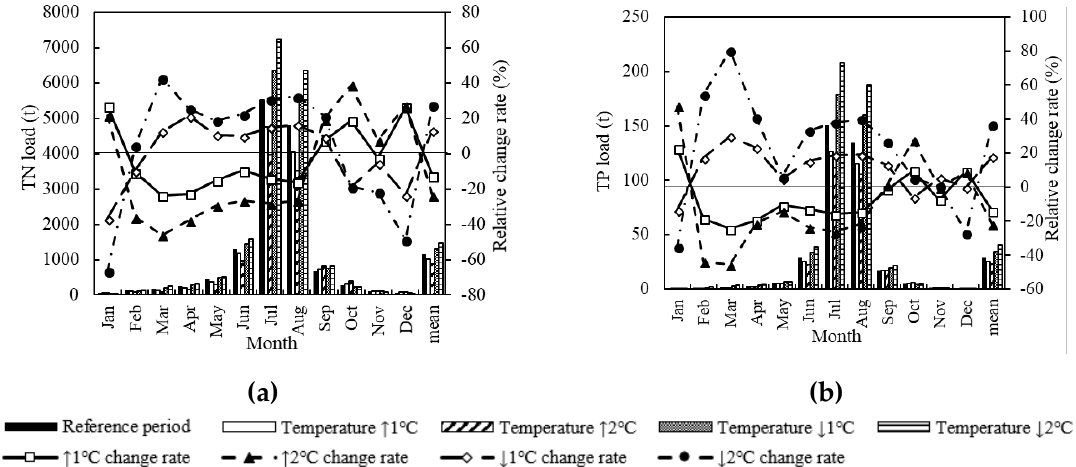
Figure 5. Monthly change of TN load ( a ) and TP load ( b ) under the Temperature Change scenario. The percentage above (including equal to) the three benchmarks was calculated (Table 5).